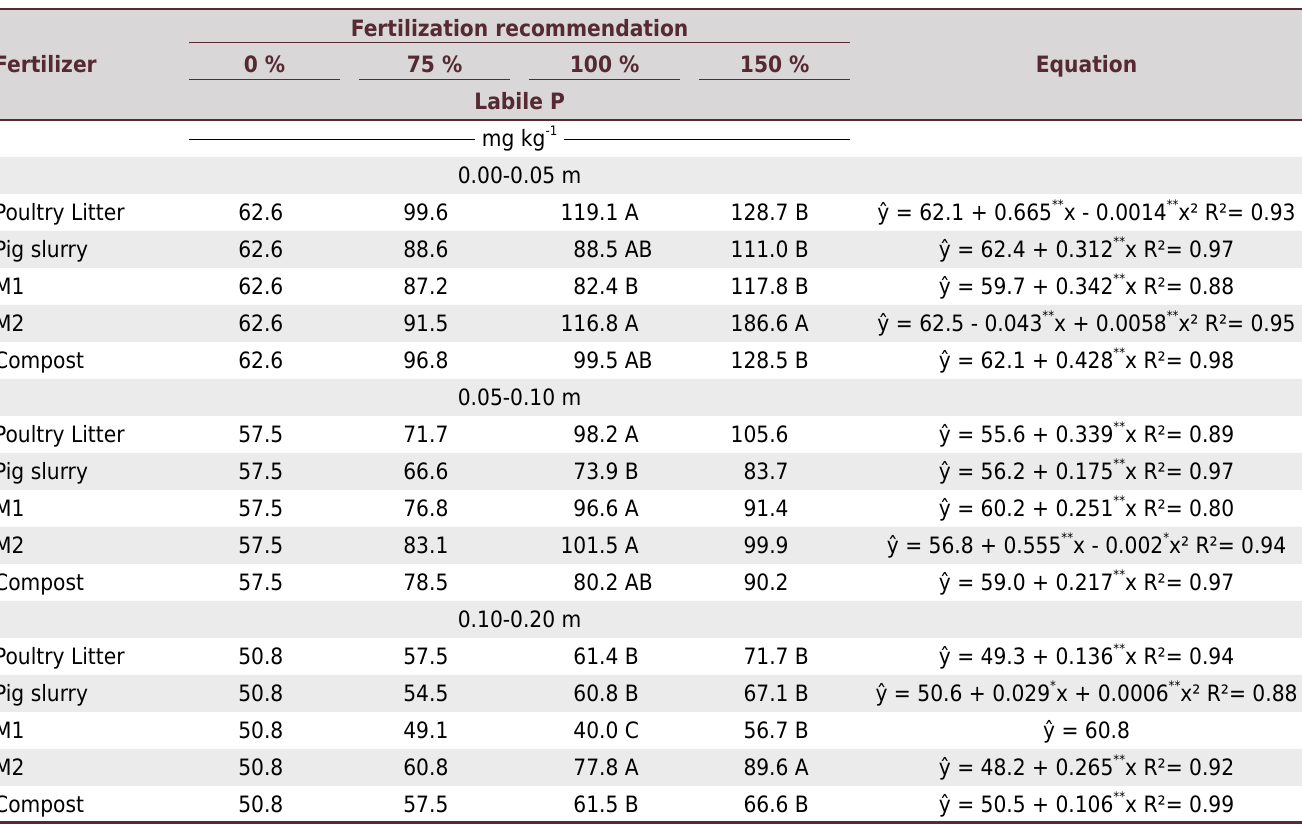
Table 4. Labile soil phosphorus fraction extracted by NaHCO 3 0.5 mol L -1 in the 0.00-0.05, 0.05-0.10 and 0.10-0.20 m layers after six years use of organic and mineral fertilizers in a Rhodic Kandiudox